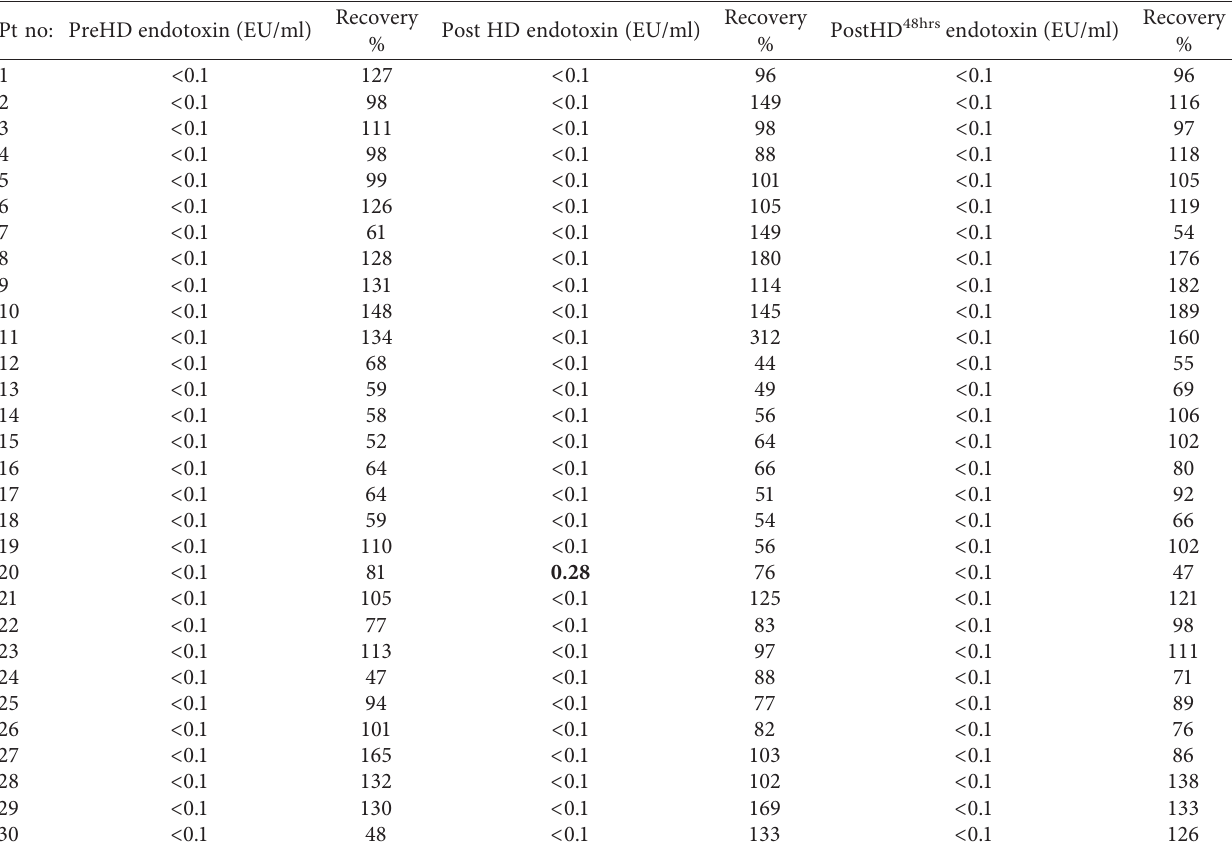
Table 2: Serum endotoxin levels measured in 30 people with kidney failure before HD (preHD), after HD (postHD), and 2 days later (postHD 48hrs ).